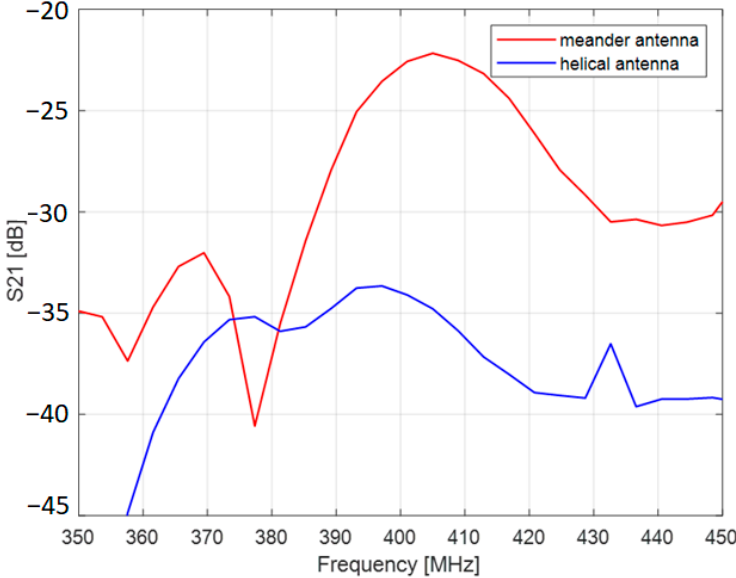
Figure 14. S11 measured and simulated for meander antenna prototype.